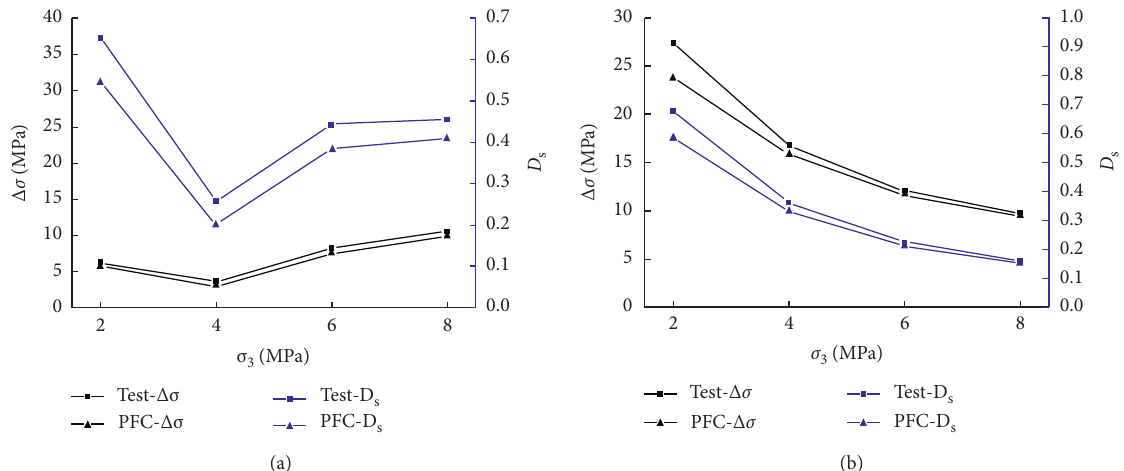
Figure 9: Comparison of rock attenuation value and attenuation coefficient. (a) Mudstone. (b) Sandstone.